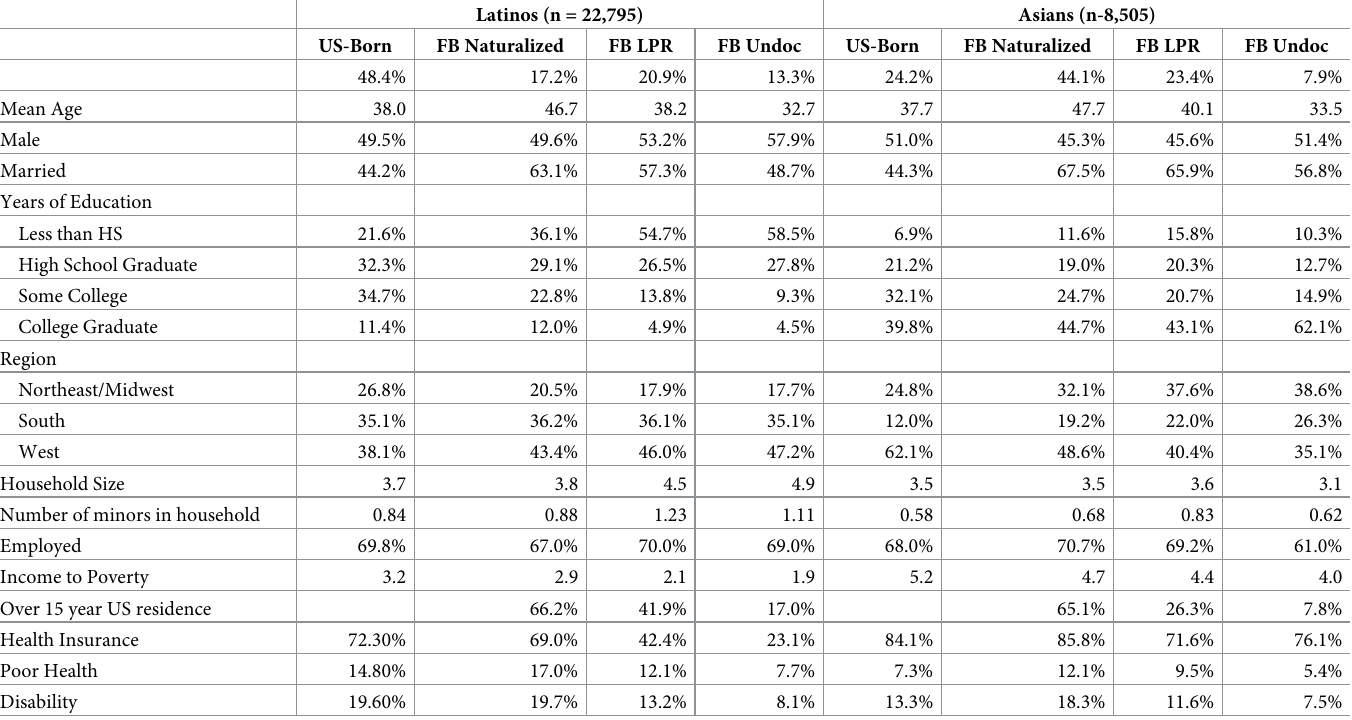
Table 1. Sample descriptives, 2001/2004/2008 Survey of Income and Program